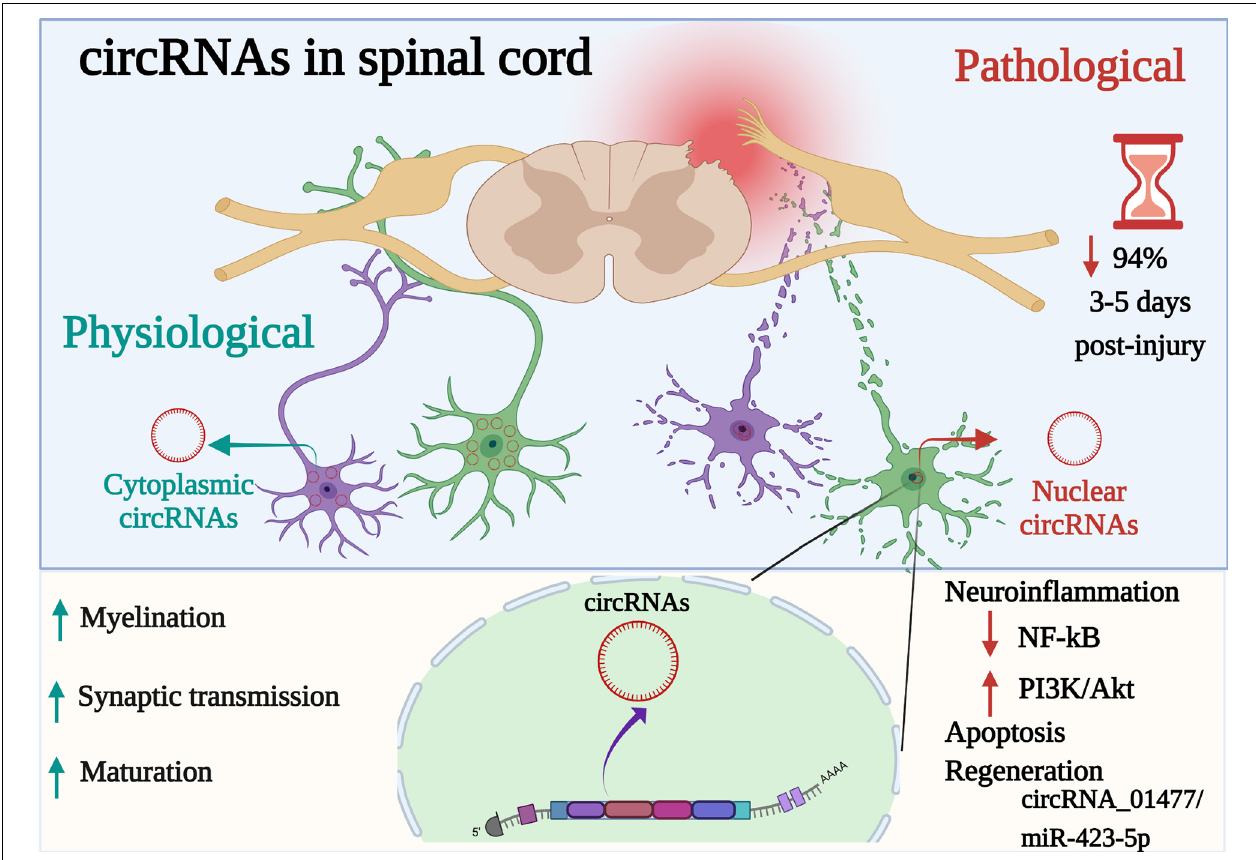
FIGURE 1 | Participation of circRNAs as key active regulators in diverse physiopathological mechanisms in the spinal cord. circRNAs are a special type of endogenous ncRNAs formed by back-splicing events via protein-coding exons. Differentially expressed circRNAs (cytoplasmic or nuclear) are implicated in biological, cellular, molecular processes and gene expression modulation at post-transcriptional level in the spinal cord. Whereas, dysregulated circRNAs (up or downregulated) have been associated with acute stages following spinal cord injury (SCI), acting as a sponge of miRNAs, suppressing or activating signaling pathways related (e.g., NF- κ B, PI3K-AkT) to signal transduction, neuroinflammation, and apoptosis but to promote regeneration. Indeed, even if 94% of cirRNAs decreased after 3–5 days post-spinal injury, circRNA_01477/miR-423-5p is a key circRNA to control regeneration. Created with